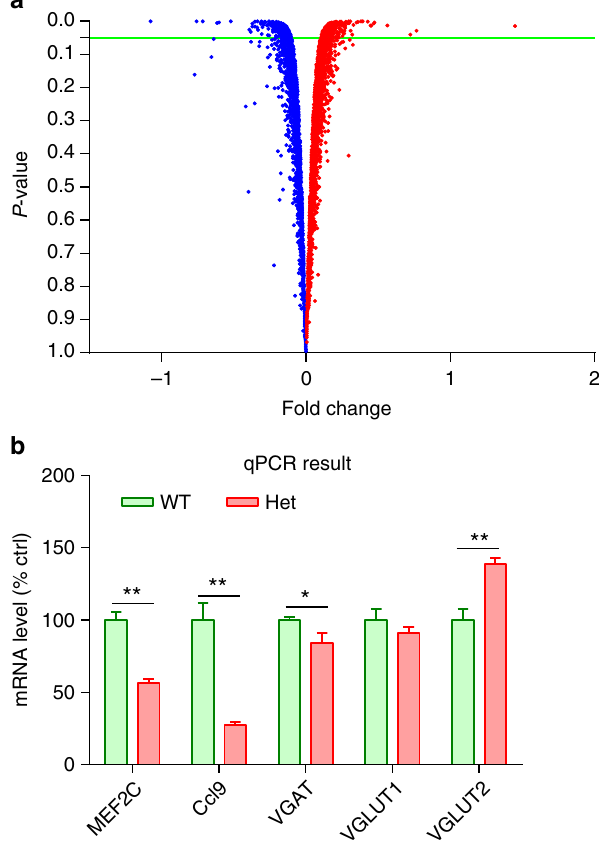
Fig. 2 Downregulation of neurogenic and synaptic genes in Mef2c -het mice by microarray analysis. a Volcano plot shows RNA expression pro fi ling in P30 Mef2c -het and WT hippocampus (red = up, blue = down, P < 0.05 indicated by green line). b Graph of qPCR experiments showing expression levels of mRNA (relative to 18S) in Mef2c -het mice as percentage of WT control (% ctrl; n = 4 per group). Data are mean ± s.e.m.; * P < 0.05, ** P < 0.01 by Student ’ s t test